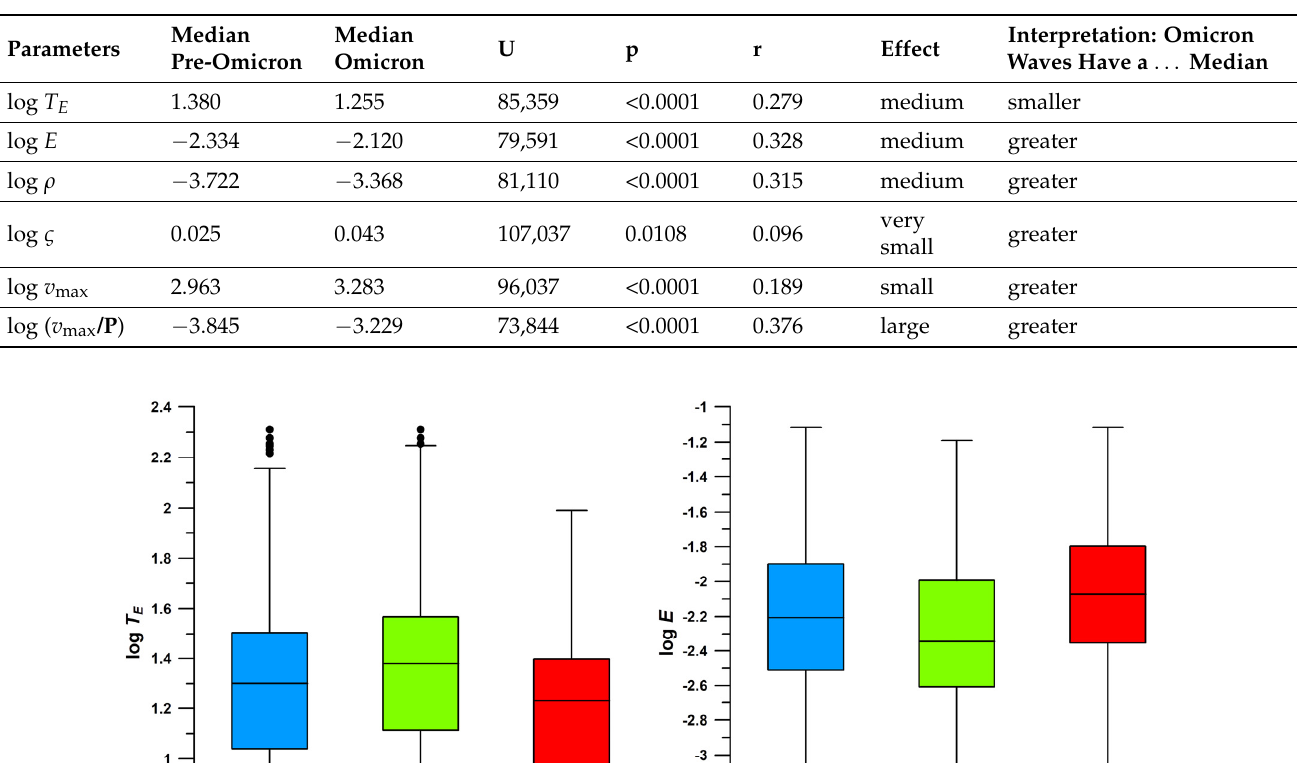
Table 2. Comparison of medians of pre-Omicron ( n = 615) and Omicron ( n = 385) waves (wave ratio 8:5); U = U-statistic value of the Mann–Whitney test; p = probability value; r = effect size; T E = duration of the effective phase; E = effectiveness (of wave management); ρ = E / T E and log ς = wave shape factor; v max = peak velocity; v max / P = peak velocity per population P .